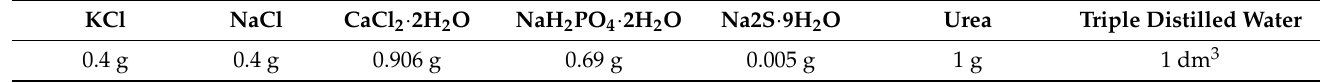
Table 2. Chemical composition of artificial saliva